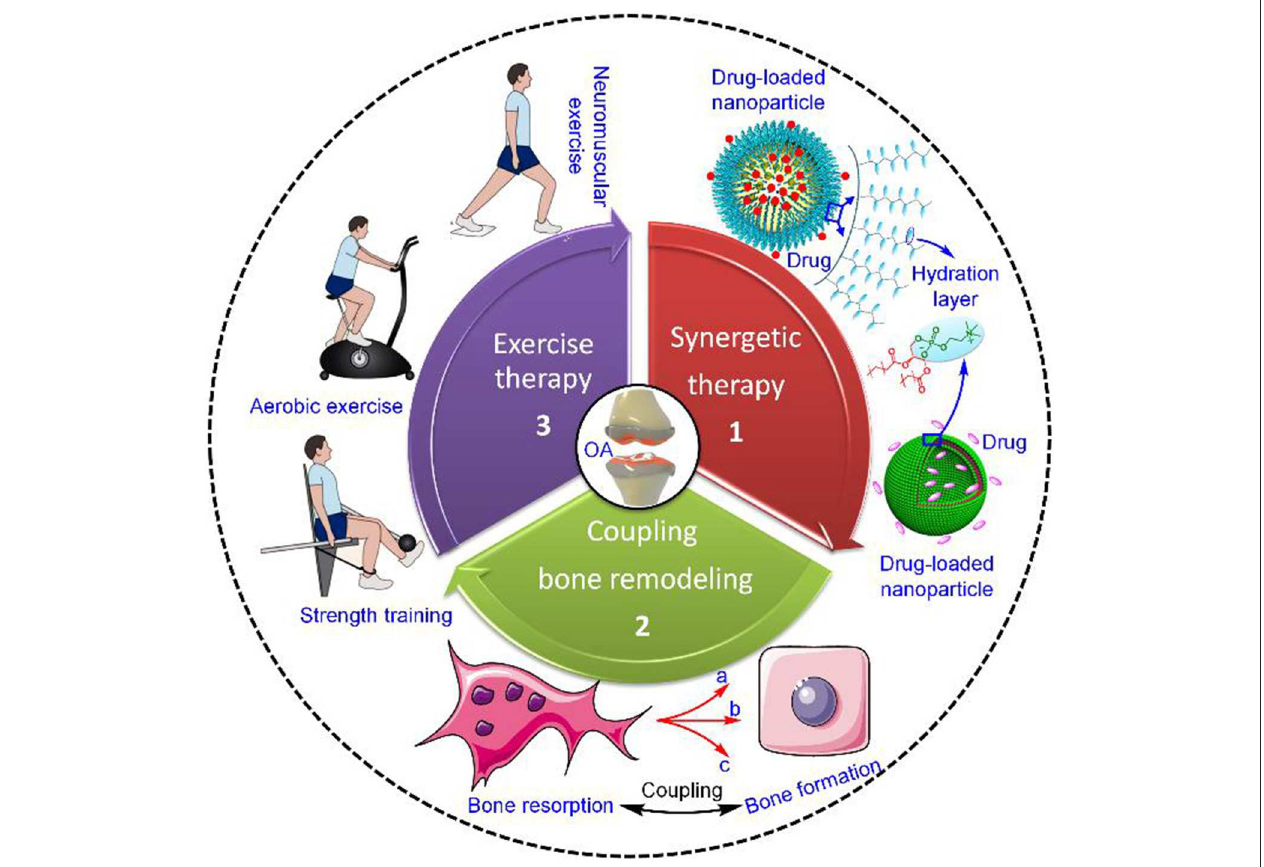
FIGURE 1 | Current strategies for OA treatment. The strategies mainly include synergetic therapy combining both lubrication and drug intervention, regulatory balance between bone resorption and formation, and exercise therapy ( Roos and Arden, 2016), Copyright 2015, Macmillan Publishers Limited. In the case of synergetic therapy, the dual-functional drug-loaded nanoparticles achieve simultaneously both enhanced lubrication on the outer hydration layer and sustained drug release in the inner core. Regarding regulatory balance between bone resorption and formation, coupling bone remodeling functions via three different levels of cellular communication, including (a) osteoclast progenitor-mesenchymal stem cell (MSC)/osteocyte communication through RANK–RANKL, (b) matricellular communication through TGF- β 1 or IGF-1, and (c) osteoclast-osteoclast communication through Sema4D–Plexin-B1. Exercise therapy is intended for modifiable OA risk factors and mainly includes neuromuscular exercise, strength training, and aerobic